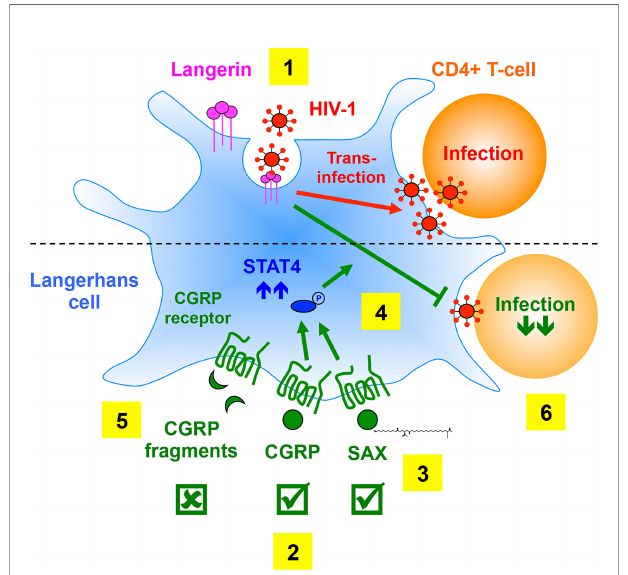
FIGURE 7 | Summary of the requirements of CGRP receptor activation for inhibition of mucosal HIV-1 transmission. (1) In LCs, HIV-1 binding to langerin induces viral internalization and subsequent degradation, while virions escaping degradation trans-infect CD4+ T-cells. (2) We previously showed that CGRP activates its cognate receptor expressed by LCs and affects a multitude of cellular and molecular process (not shown), resulting in signi fi cant inhibition of mucosal HIV-1 trans-infection in-vitro and ex-vivo . (3) We show in the present study that SAX, a long-acting metabolically stable analogue of CGRP, also activates the CGRP receptor. (4) Both CGRP and SAX increase expression of langerin (not shown) and STAT4 (that can be readily phosphorylated upon subsequent cytokine stimulation), which result in inhibition of HIV-1 trans- infection in-vitro and ex-vivo . (5) In contrast, several CGRP peptide fragments fail to activate the CGRP receptor and to increase langerin/STAT4 expression, and accordingly lack anti-HIV-1 activity. (6) CGRP-mediated inhibition of HIV-1 dissemination from LCs to CD4+ T-cells might permit their long-term maintenance in the BLT model of mucosal HIV-1 infection in-vivo